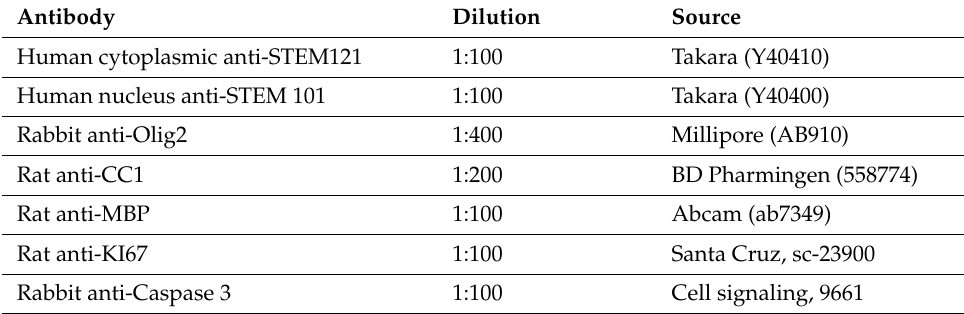
Table 3. List of primary antibodies used for in vivo cell